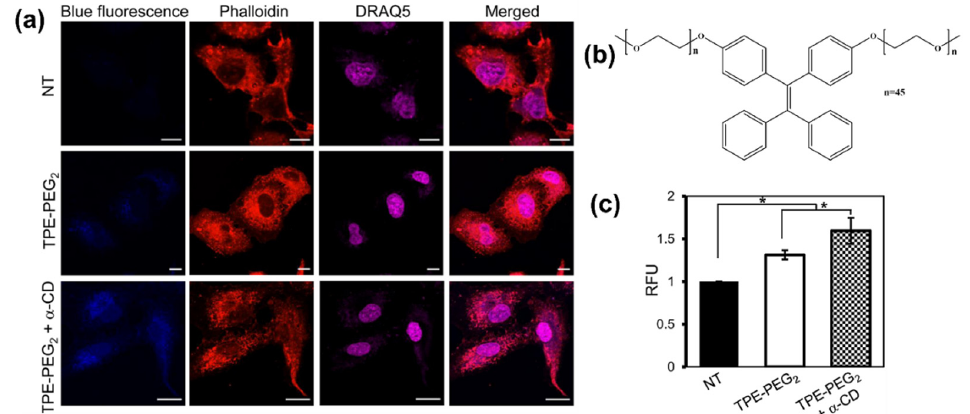
Figure 14. ( a ) Confocal images illustrating the cellular internalization of the TPE-PEG 2 and combining TPE-PEG 2 and α -CD using A549 cells and investigated for 4 h at 37 °C. ( b ) Molecular structure of the TPE-PEG 2 and ( c ) bar graph image representing relative fluorescence intensity TPE-PEG 2 in respective cells, in which “*” represents three independent experiments from five random field per experiments i.e. * p < 0.05. Reprinted from reference [90] with the permission American Chemical Society.